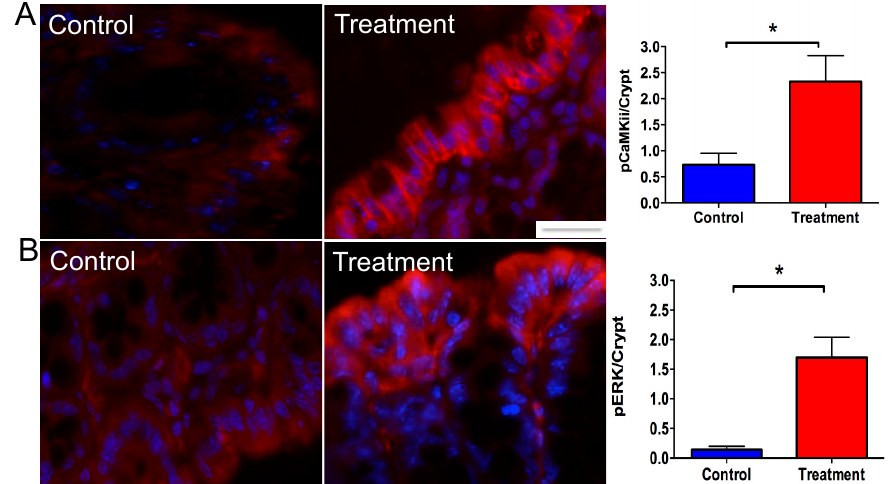
Figure 5. Stimulation of colonic mucosa with GPR84 agonist lauric acid (25 mmol/L), GPR119 agonist PSN 375963 (10 μ M), GPR40 agonist AS 2034178 (10 μ M), and TGR5 agonist TS-G 1005 (10 nM) activates both pERK and pCamKII intracellular pathways, as shown by a significant increase in the number of IR cells ( A , B ). Both pERK and pCamKII IR cells were commonly observed to be the most superficial cells, with cells within crypts sparsely stained ( A , B ). N = 3. The error bars show SEM, and significance is p < 0.05 as denoted by *. The scale bar = 10 μ m.